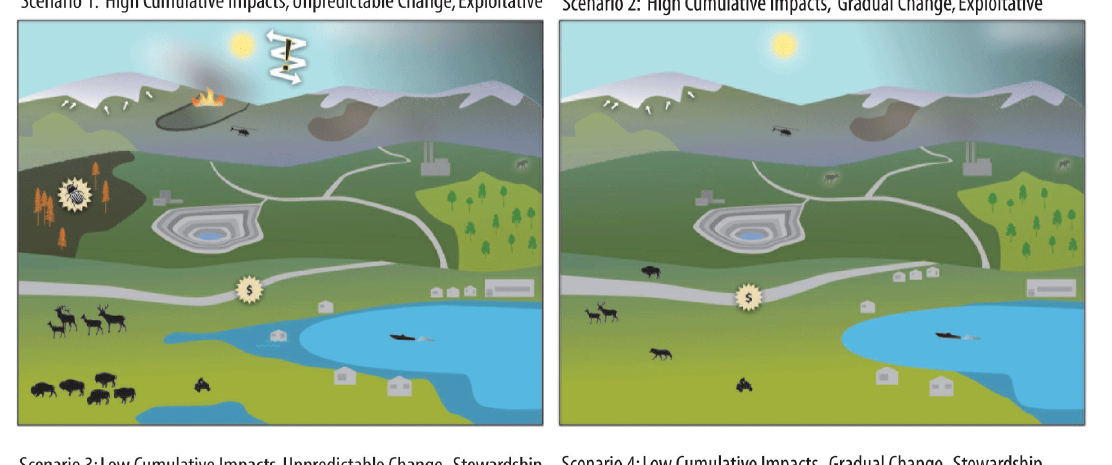
Fig. 2 . Illustrations of the four scenarios, highlighting major themes and events within each. Full scenario narratives can be found in Appendix